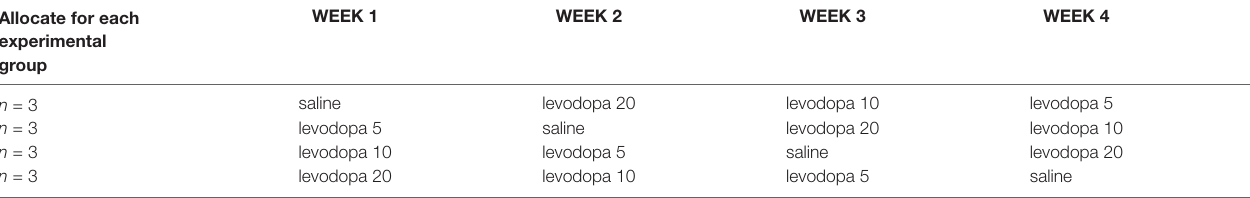
TABLE 1 | Specification of the order of treatments received by the four different experimental groups according to a Latin square design. Allocate for each